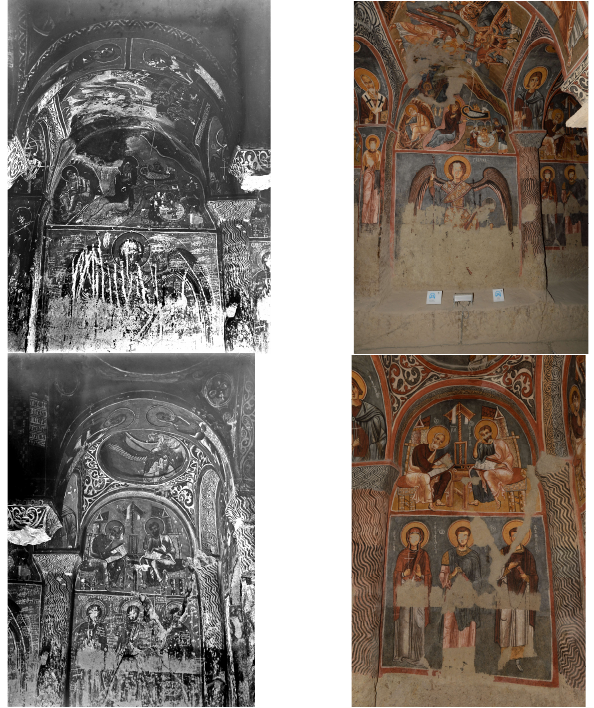
Figure 2. Historical archives photographs and images of the actual state of the paintings in Karanlık church.